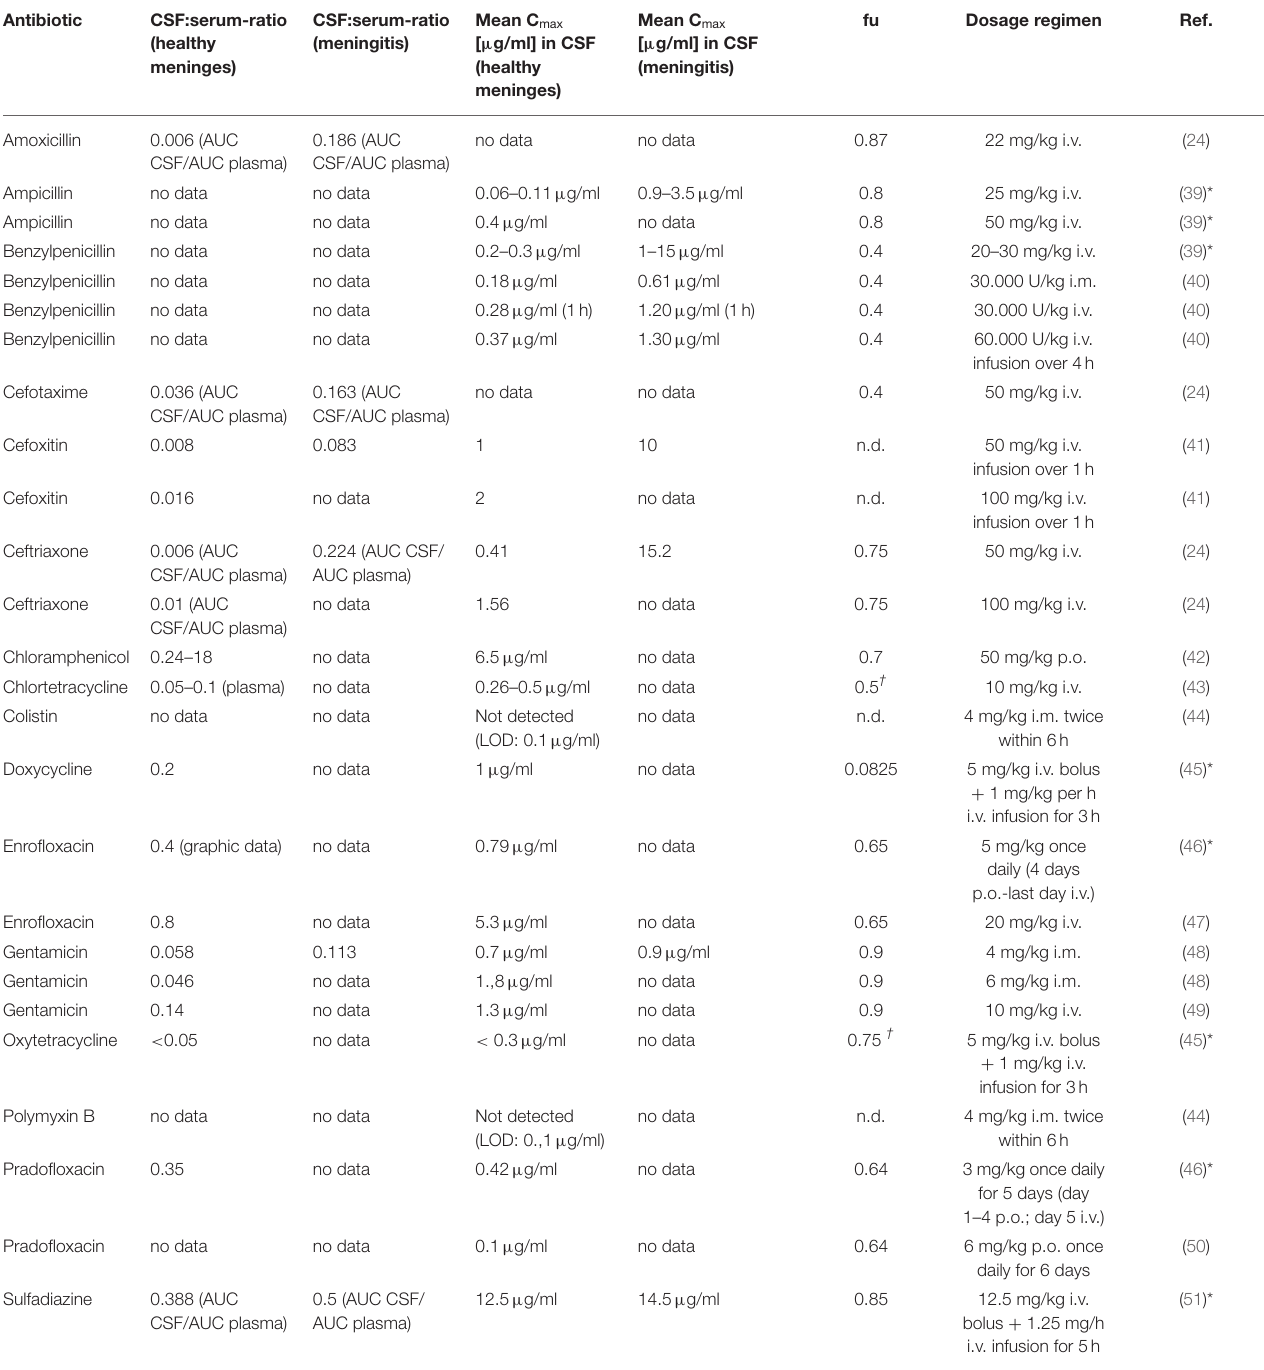
TABLE 4 | Pharmacokinetic data of antibiotics in CSF of dogs. Antibiotic CSF:serum-ratio (healthy